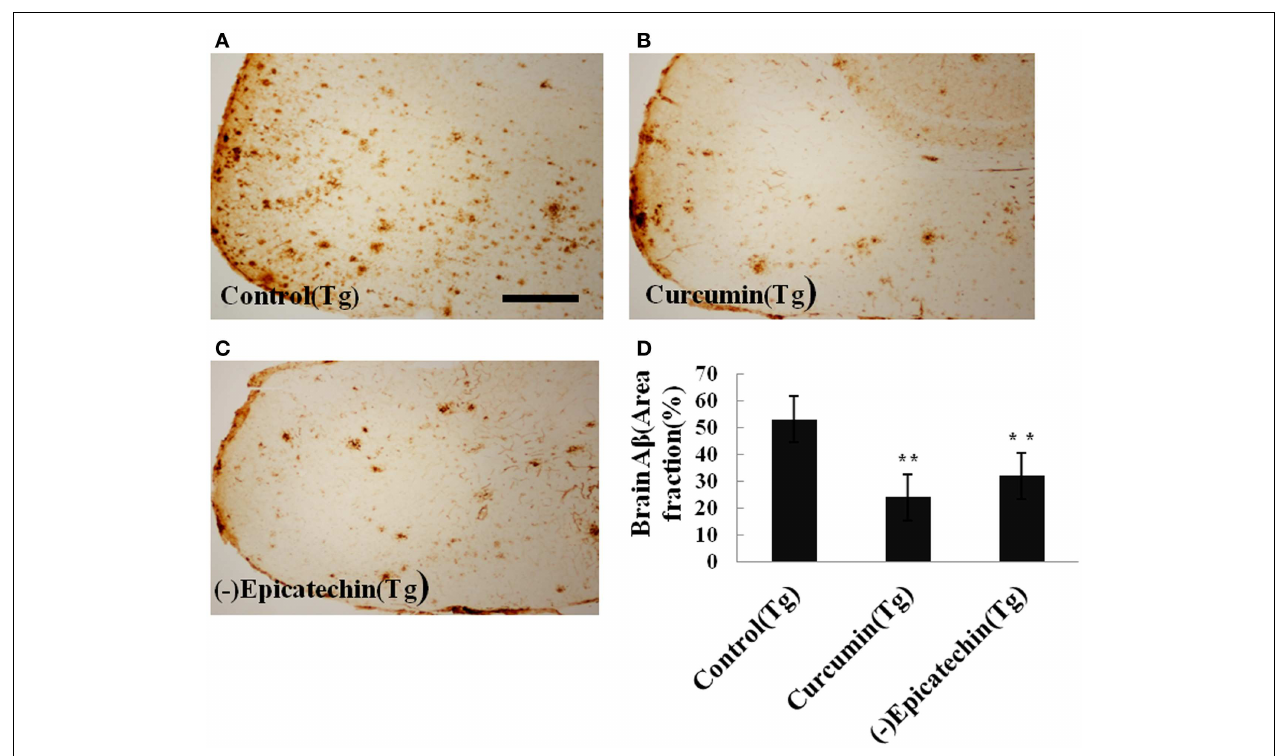
hippocampus among groups. Statistical analysis showed a significant decrease in the number of plaques in the brain treated with ( − )epicatechin and curcumin diets. P < 0.05 versus APP/PS1 transgenic mice fed with control diet. Scale bar =